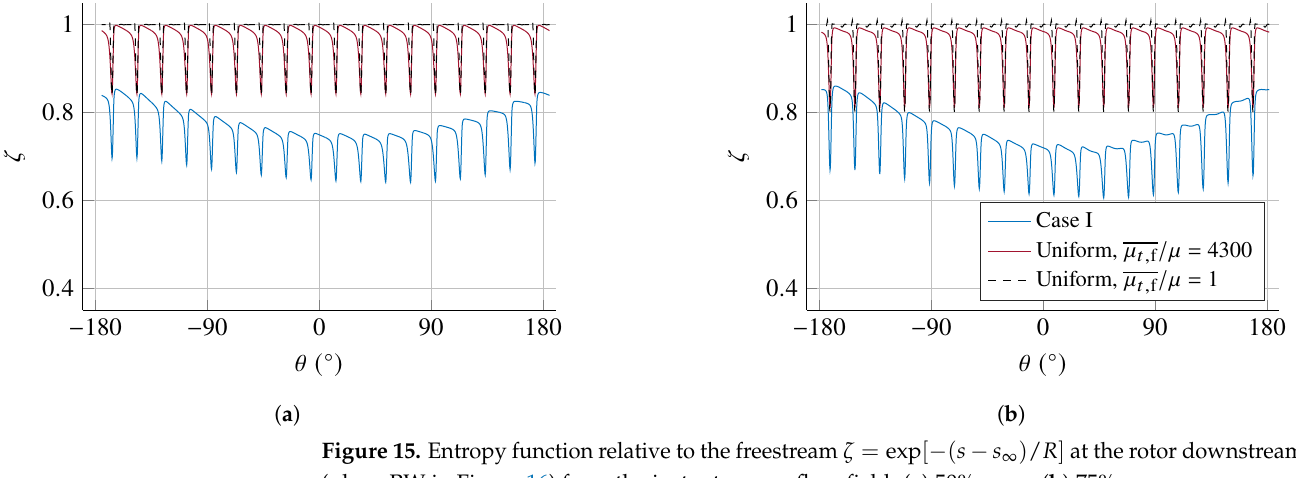
Figure 15. Entropy function relative to the freestream ζ = exp [ (plane RW in Figure 16) from the instantaneous flow field. ( a ) 50% span. ( b ) 75% span.